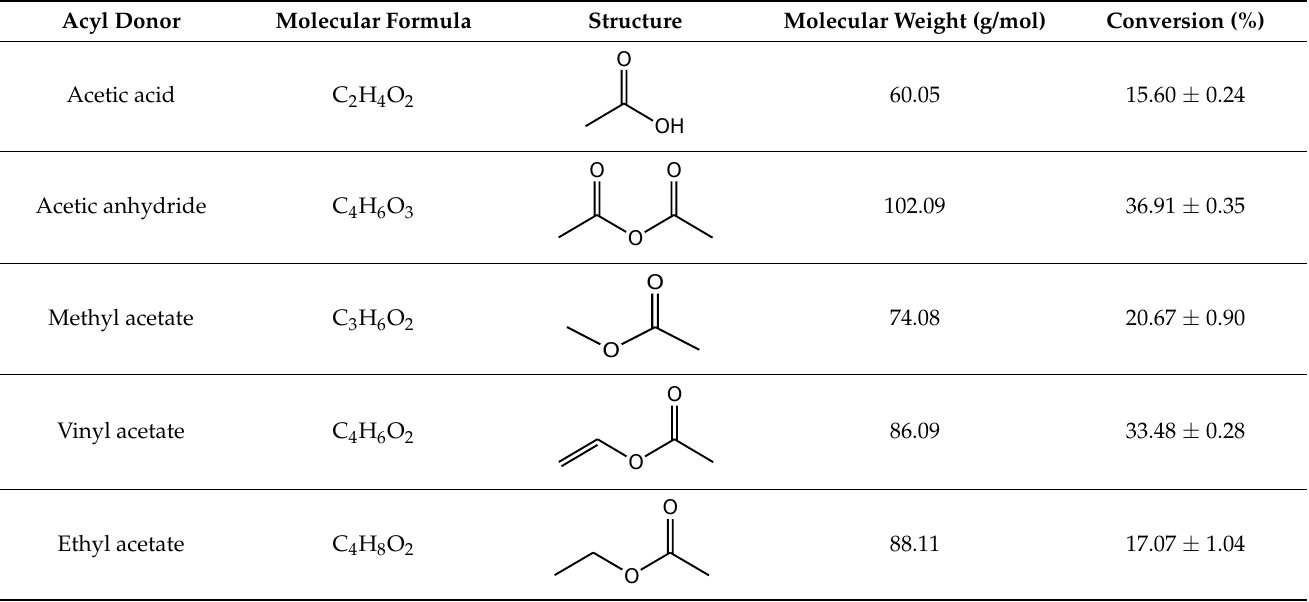
Table 3. Information on acyl donors and the corresponding conversion rate of naringin acetate.